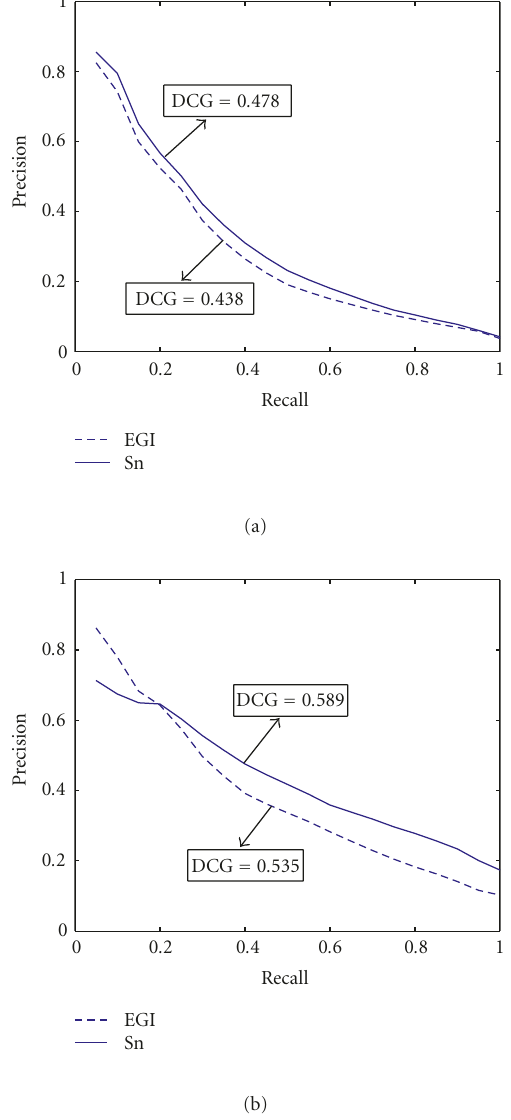
Figure 8: Precision-recall curves for CAH, [Sr1,Sr2,Sr3,Sr4] (con- catenated) and Sr (joint) on PSB test set (a) and SCUdb (b).